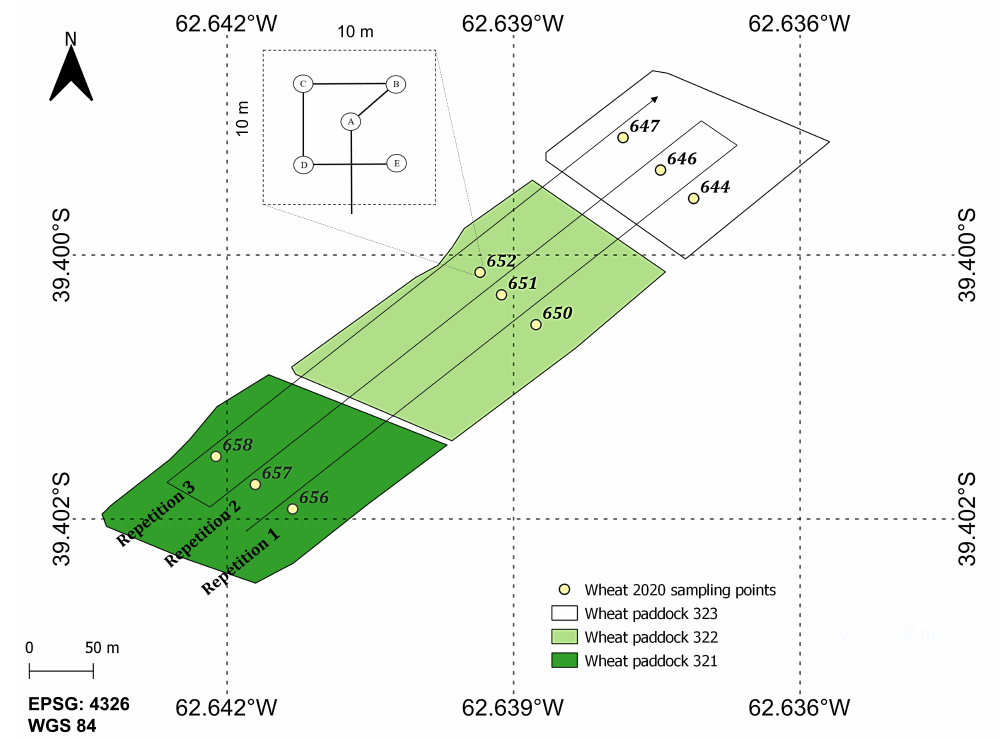
Figure 2. Layout of measurement design for the 2020 campaign at the BVCR study site: three ESUs were defined per wheat paddock and sampling approach for each elementary sampling unit, partly adapted from [69]. Reference system: WGS84 (EPSG